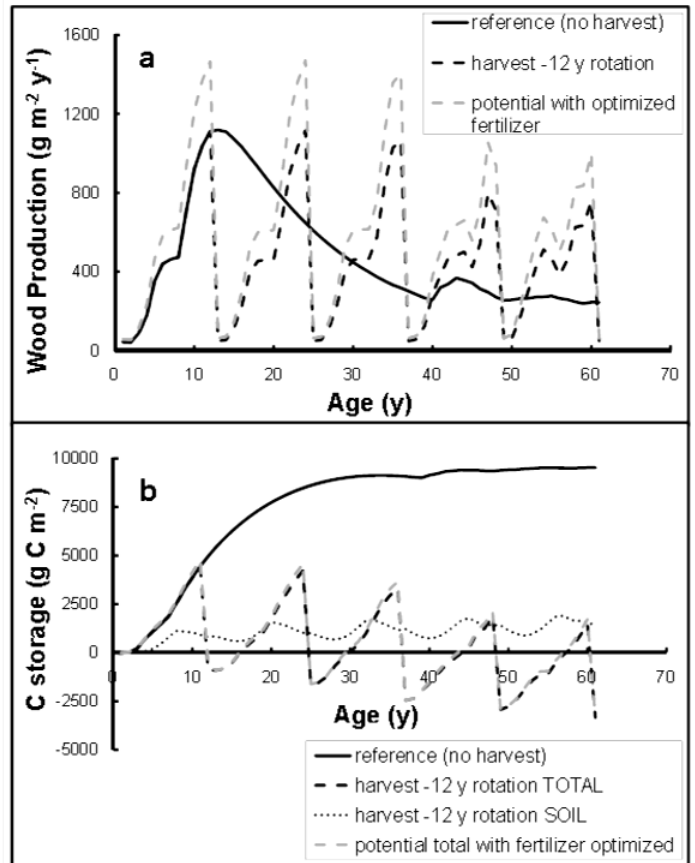
Figure 3. Simulated wood production ( a ) and C storage ( b ) in an abandoned loblolly pine plantation (no harvest- solid line) and a plantation harvested and replanted at 12 y intervals (dashed line). The dotted line indicates C sequestration in soil only, and shaded dashed lines represent the potential production ( a ) and C storage ( b ) if fertilizer applications were